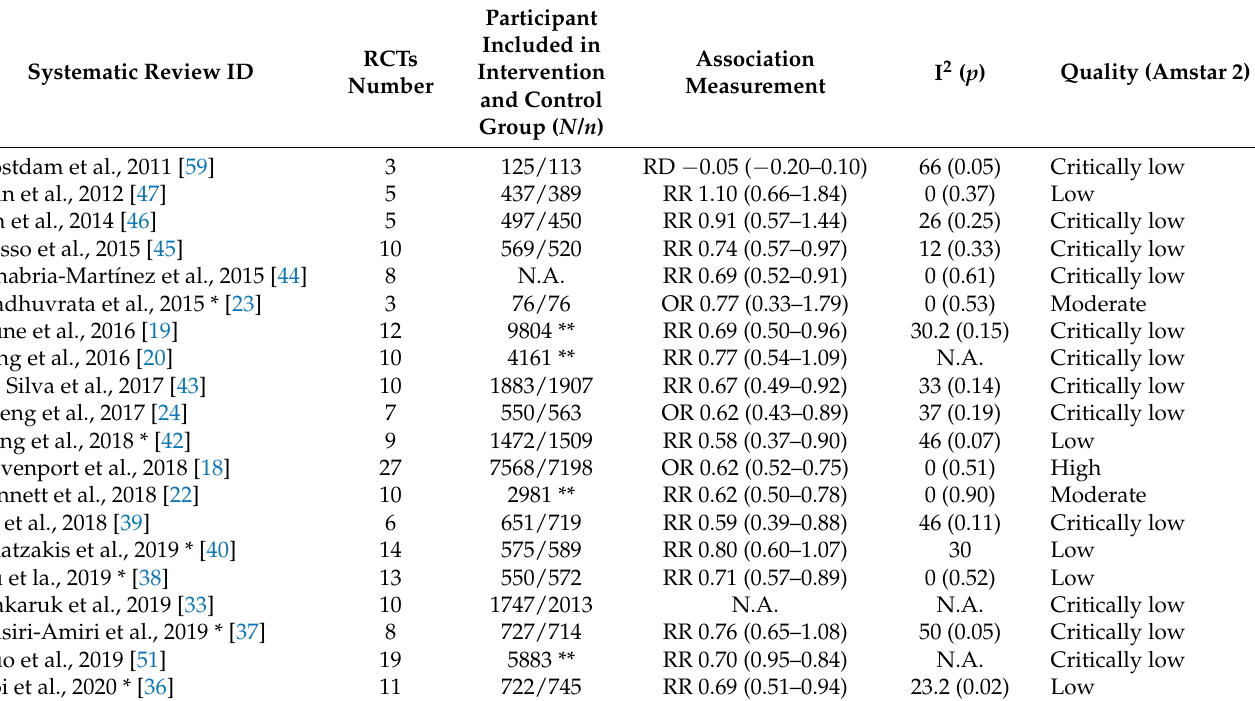
Table 2. Systematic reviews finding including physical activity intervention in reducing